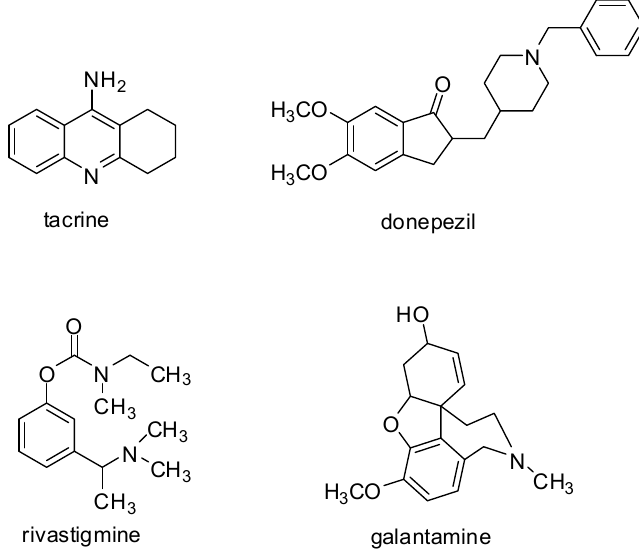
Figure 1. Cholinesterases inhibitors used in Alzheimer’s disease (AD) treatment. Tacrine was withdrawn, due to its hepatotoxicity, but it is still used in experiments as a reference